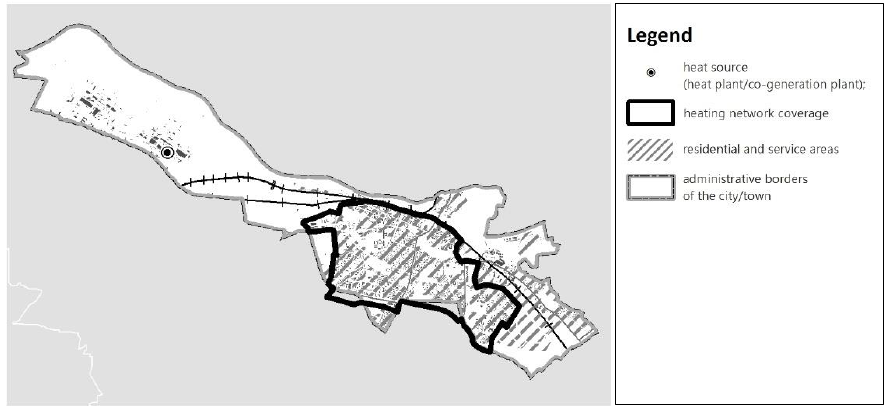
Figure 5. Areas intended for housing and service development, and the range of the district heating network in Głogów. * HSAs—housing and service areas.